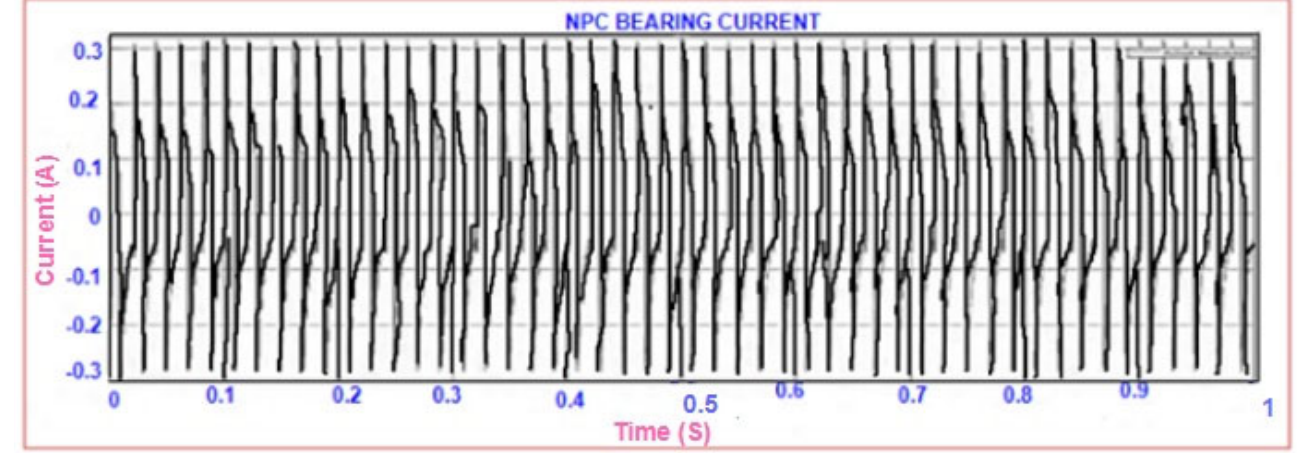
Figure 25. CBC of modified ANN ‐ based sensorless induction motor with NPC inverter.